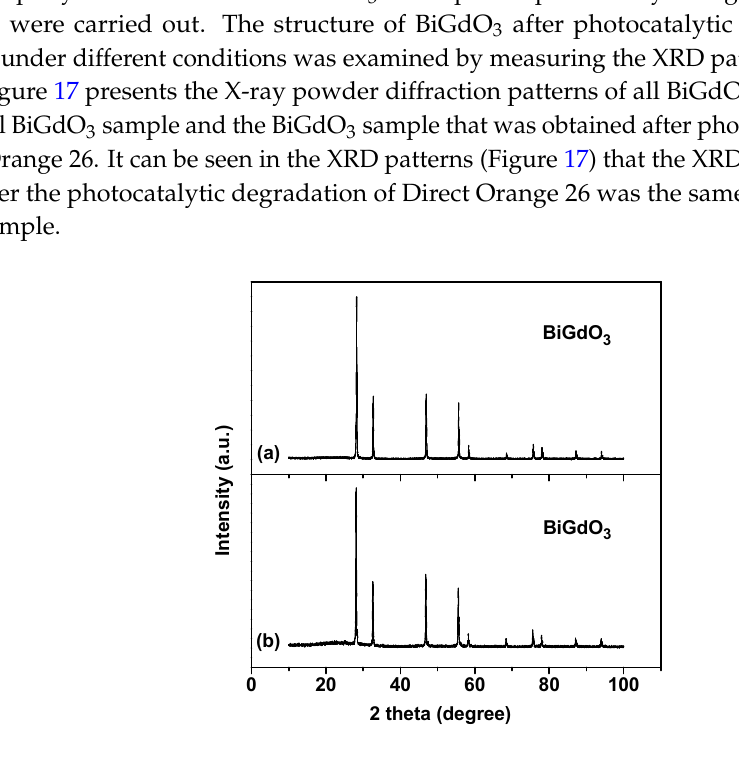
Figure 17. X-ray powder diffraction patterns of every BiGdO 3 sample: ( a ) the original BiGdO 3 sample; and ( b ) the BiGdO 3 sample after photocatalytic degradation of Direct Orange 26.